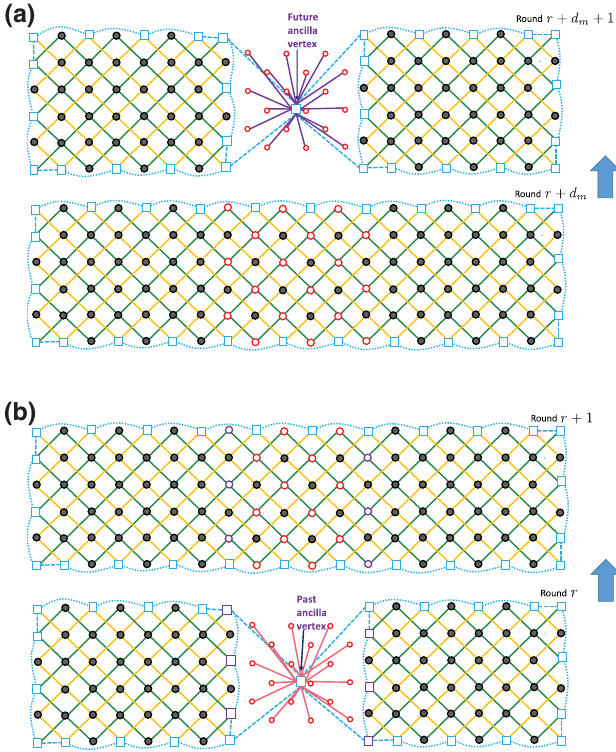
FIG. 5. Various 2D slices of the matching graph used for per- forming an X ⊗ X Pauli measurement via lattice surgery. (a) The 2D slices of the surface-code matching graphs for syndrome- measurement rounds r + d m (bottom) and r + d m + 1 (top). The graph in round r + d m + 1 includes the future ancilla vertex, with future vertical edges (solid purple edges) connecting to the par- ity vertices (white vertices circled in red) of the matching graph in round r + d m . (b) The 2D slices of the surface-code matching graphs for syndrome-measurement rounds r (bottom) and r + 1 (top). The graph in round r includes the past ancilla vertex with past vertical edges (solid pink edges) connecting to the parity vertices (white vertices circled in red) of the matching graph in round r + 1. The transition vertices are the purple boundary ver- tices of the graph prior to the merge (note that transition vertices appear in rounds 1 to r ), in addition to the purple parity vertices in round r +